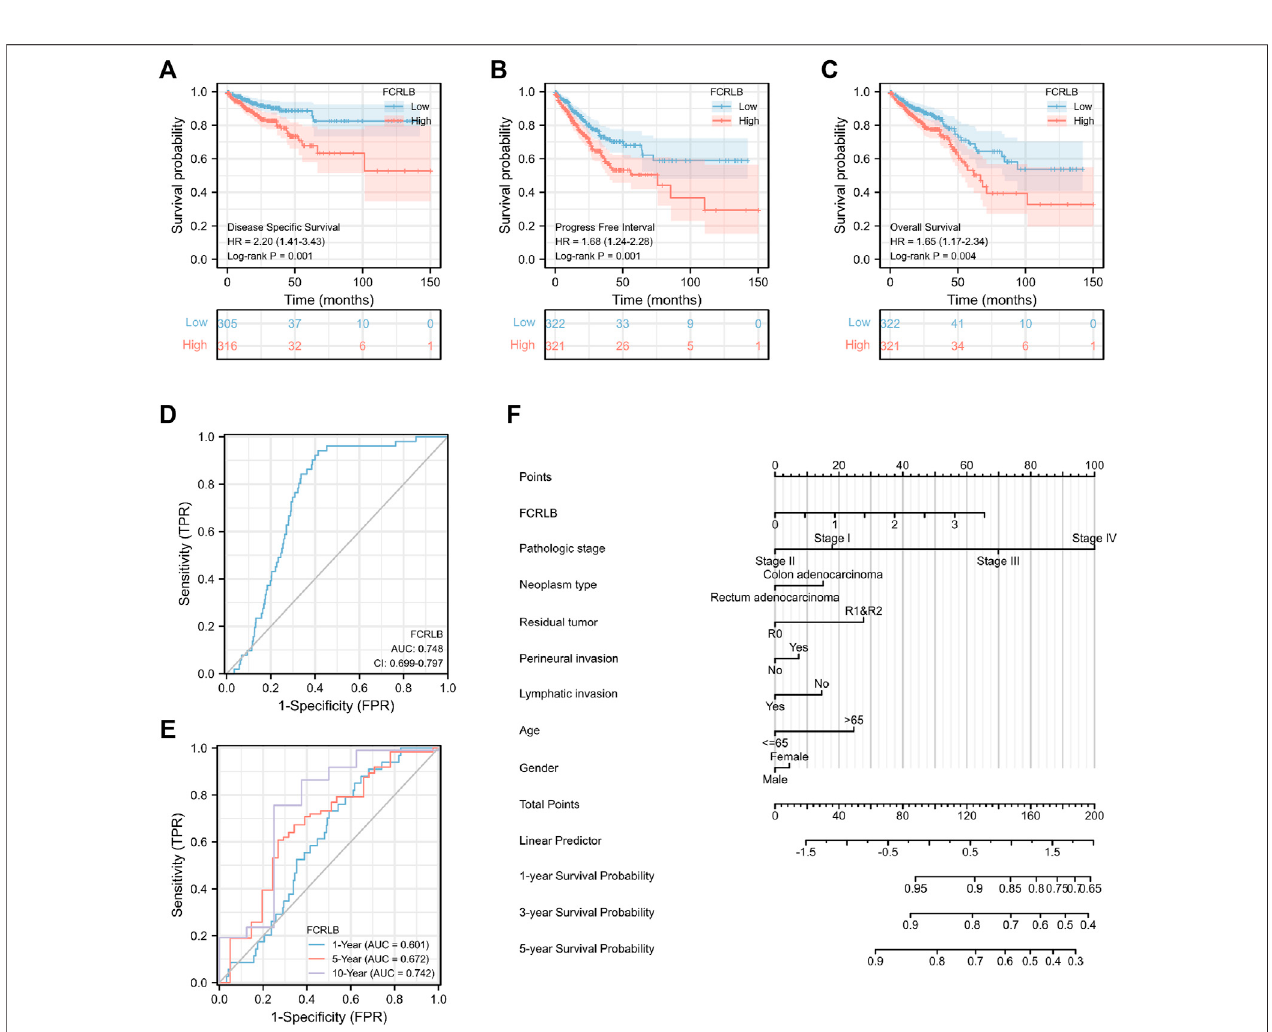
FIGURE 4 | Overexpression of FCRLB was associated with poor prognosis in the TCGA CRC cohort. (A) Kaplan-Meier analyses for OS according to FCRLB expression inCRC patients intheTCGACRC cohort. (B) Higherexpression ofFCRLB wascorrelatedwithlessfavorable DSSinCRC patients intheTCGACRC cohort. (C) Higher FCRLB expression level was correlated with poorer PFI in the TCGA CRC cohort. (D) The predictive value of FCRLB was evaluated by ROC curve. (E) Time- dependent ROC curves analysis of FCRLB. (F) OS Nomogram representation of the multivariate model.